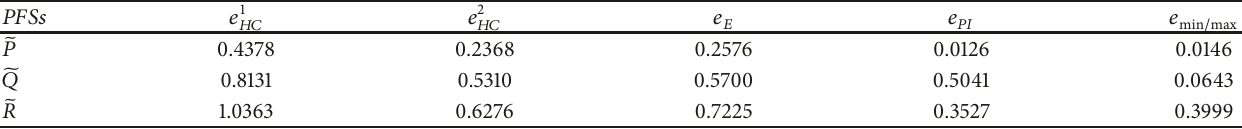
Table 1: Comparison of the degree of fuzziness with different entropy measures of PFSs.